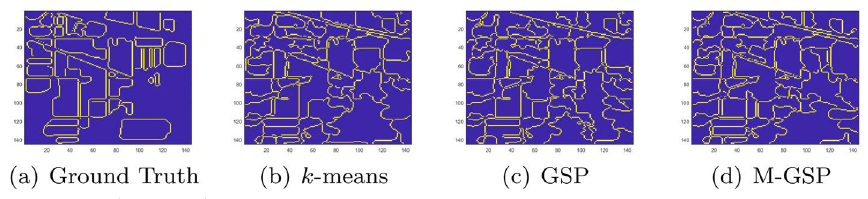
Fig. 13 Boundaries in Indian